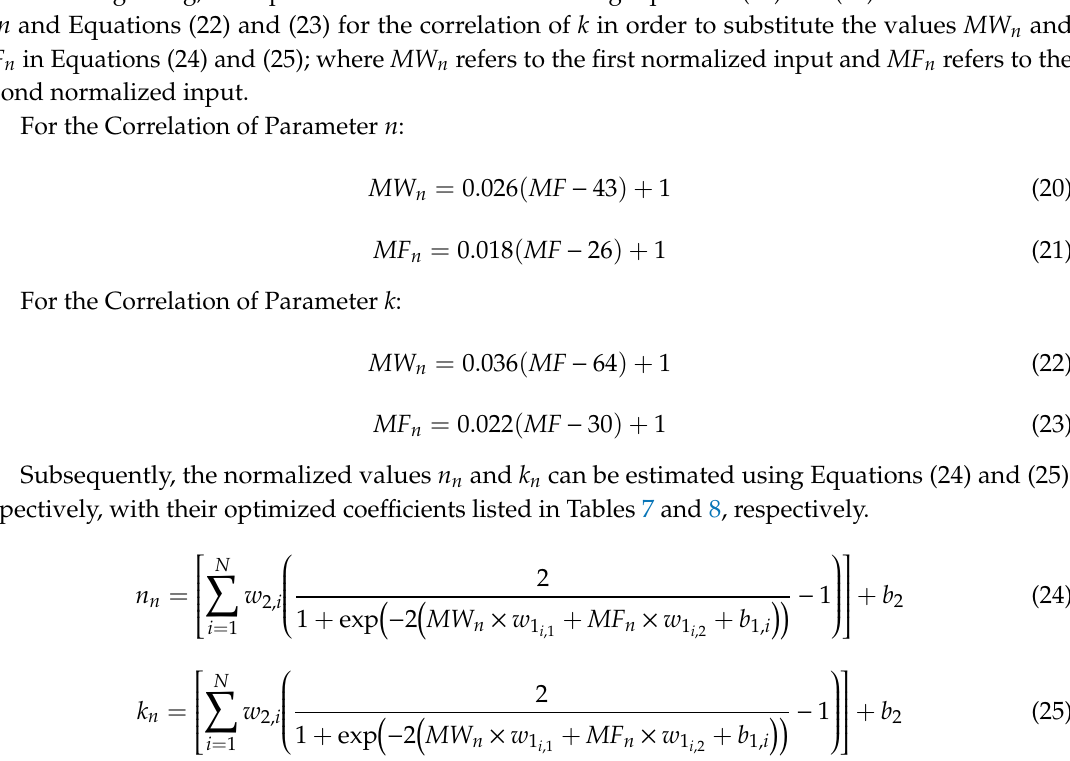
k in Equation (25). n